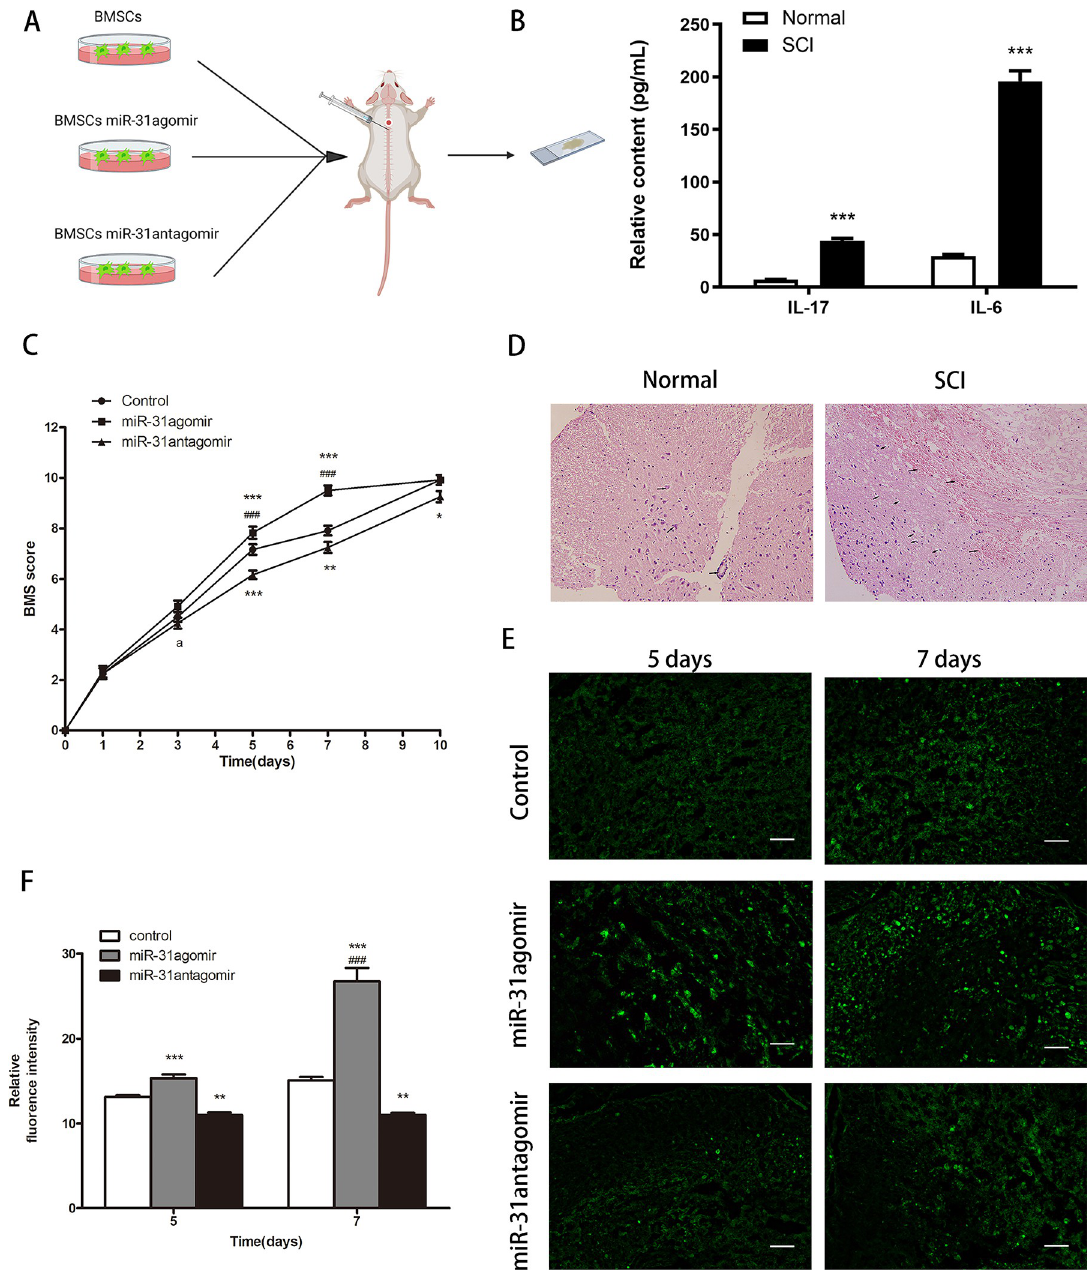
Fig 6. Establishment of SCI model and the effect of miR-31 on BMSCs migration in vivo. A Schematic diagram of cell transplantation. B Relative levels of IL-6 and IL-17 in normal and spinal cord injured mice. C Assessment of functional repair after spinal cord injury in mice by BMS score. D The morphology of the normal and post-injured spinal cord was observed by HE staining. The arrow in the normal spinal cord points to the central cord and neurons; the arrow in the injured tissue points to the red blood cells and vacuoles. Scar bar: 50 μ m. E The migration of bone marrow mesenchymal stem cells within the spinal cord was observed by frozen sections on days 5 and 7. Scar bar: 50 μ m. F Statistical results of the relative fluorescence intensity of migrating BMSCs within the spinal cord. Dates are presented as mean ± SD (n = 5,6,12). Statistical analysis: Within group compared to control, � P < 0.05, �� P < 0.01, ��� P < 0.001; between groups compared to 3,5 days miR-31 agomir, ### P < 0.01; a P < 0.05 indicates miR-31 antagomir compared to miR- 31